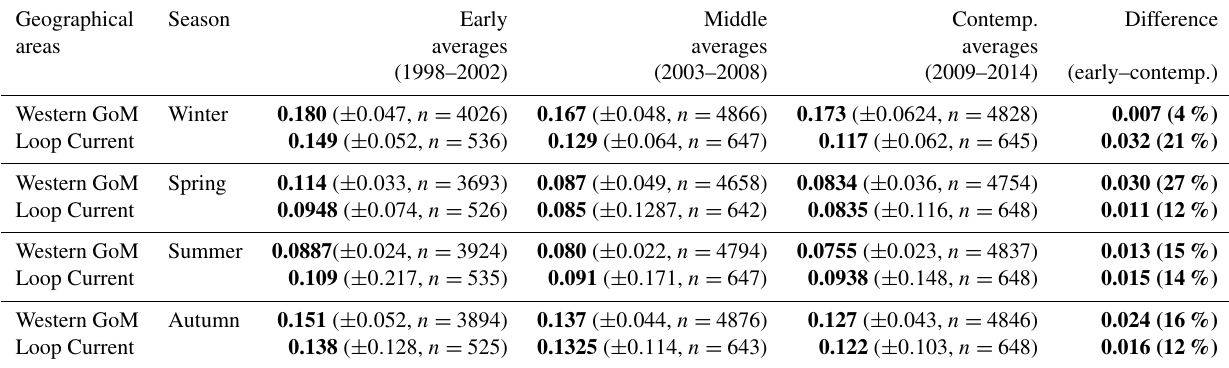
Table 1. Average bold numbers for Chl a concentrations (mgm − 3 ) and differences (mgm − 3 ; %) between early and contemporary averages at two geographical areas: 95.5 ◦ W, 22.12 ◦ N and 91.5 ◦ W, 25.87 ◦ N (Western GoM) as well as 86 ◦ W, 22.12 ◦ N and 84.75 ◦ W, 23.37 ◦ N averages in bold. The standard deviations and the number of pixels considered are shown in parentheses. Geographical Early Middle